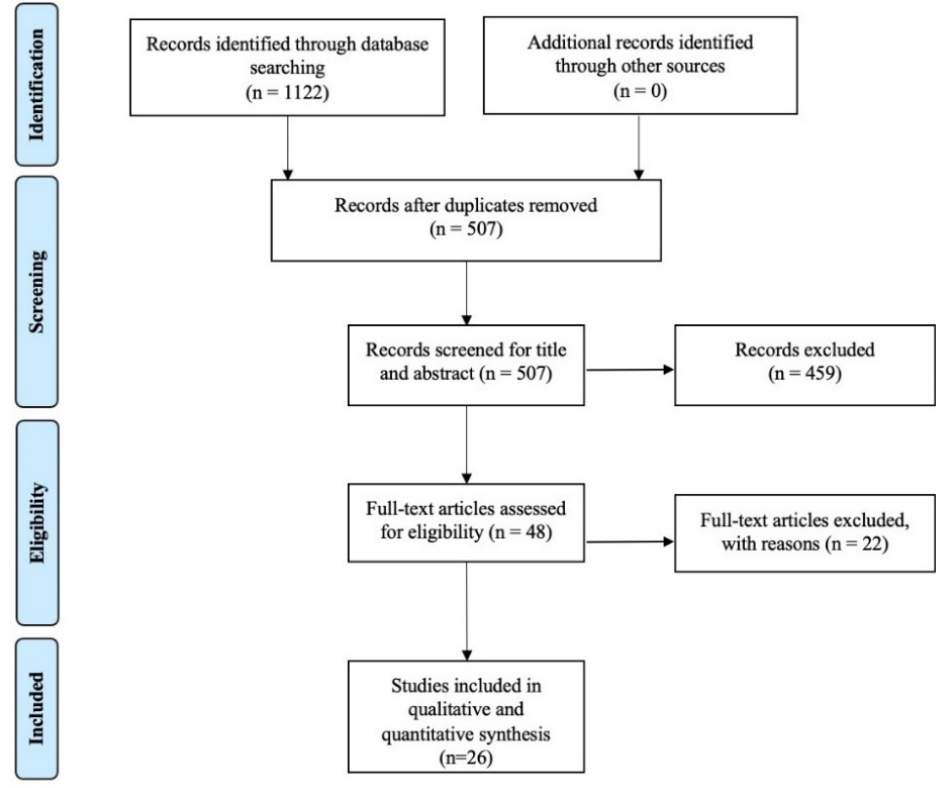
Figure 1. PRISMA flow chart.